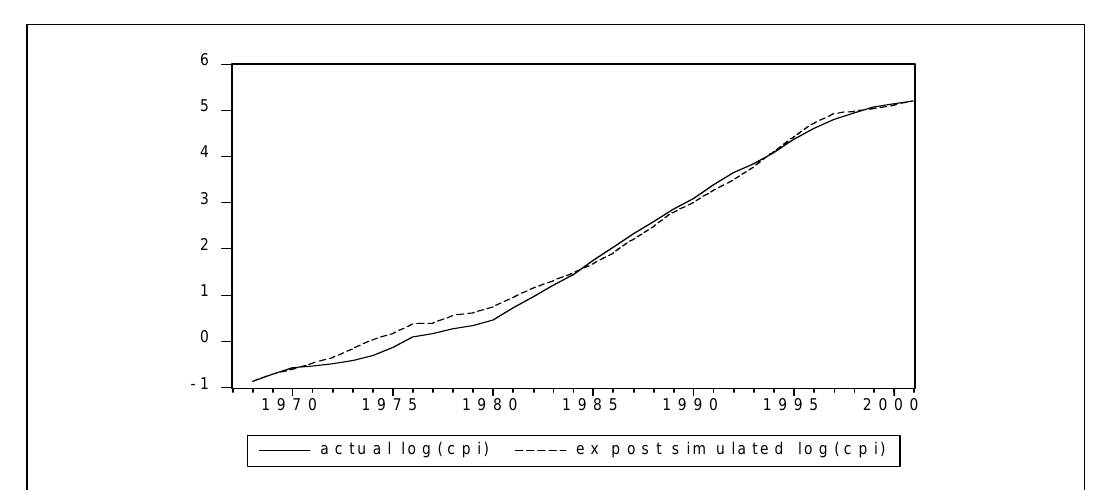
Figure 1 The overall dynamic fit of log(cpi)